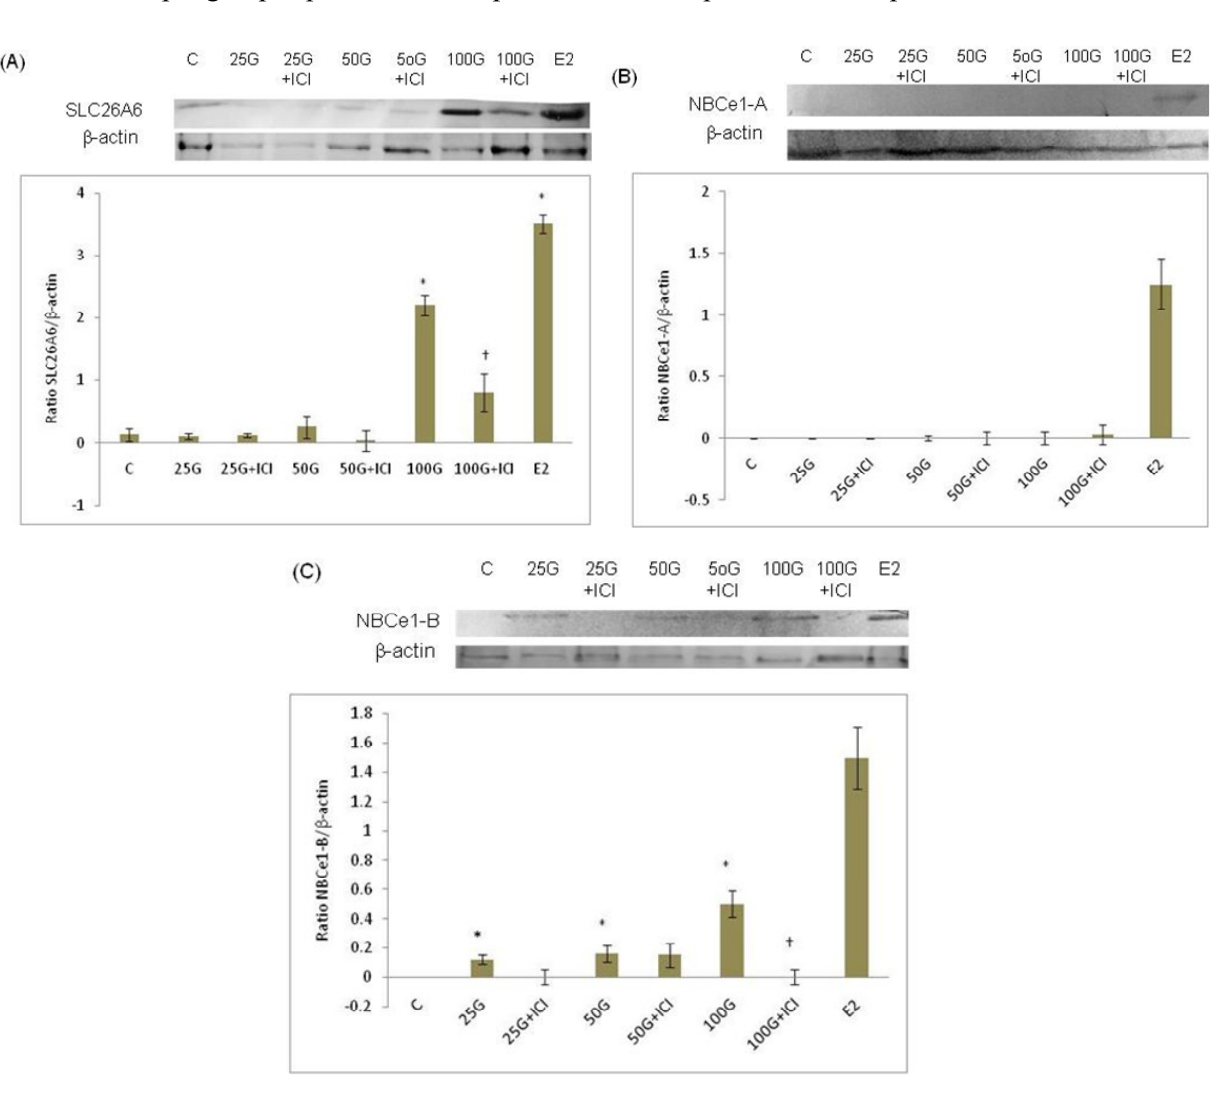
Figure 3. Protein expression analyses of ( A ) SLC26A6; ( B ) NBCe1-A; and ( C ) NBCe1-B of the whole uterine homogenates from rats treated with various doses of genistein (25, 50 and 100 mg/kg/day). An increase in SLC26A6 and NBCe1-B protein expression was observed with increasing doses of genistein, with the maximum expression occur following treatment with 100 mg/kg/day genistein, Concomitant administration of ICI 182780, an estrogen receptor blocker significantly reduced the expression of both transporters’ protein under genistein effect. The expression of SLC26A6 and NBCe1-B following high dose (100 mg/kg/day) genistein treatment were significantly lower than estrogen treatment (positive control). Higher expression of SLC26A6 was observed as compared to NBCe1-B following 100 mg/kg/day genistein treatment. NBCe1-A protein was however not expressed in the uterus under genistein effect and was minimally expressed following estrogen treatment. C: control; ICI: ICI 182780; 25G: 25